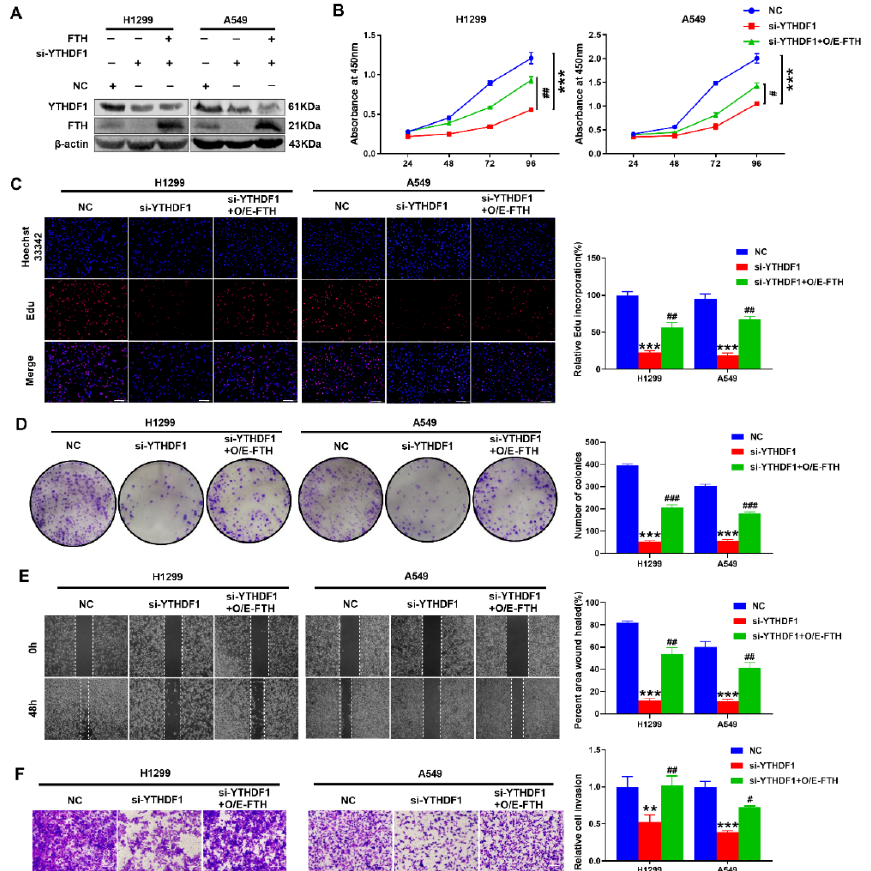
Figure 5. FTH overexpression effectively altered YTHDF1 knockdown-induced inhibition of lung cancer cell progression. ( A ) Western blot analysis of the transfection efficiency of FTH in lung cancer cells. ( B – D ) CCK-8 assay, Edu incorporation assay and colony formation assay of lung cancer cells transfected with FTH and si-YTHDF1, respectively or corporately. ( E , F ) Wound-healing assay and Transwell Matrigel invasion assay of lung cancer cells transfected with FTH and si- YTHDF1, respectively or corporately. Scale bar, 100 µ m. ns, not significant; ** p < 0.01; *** p < 0.001; # p < 0.05; ## p < 0.01; and ### p <